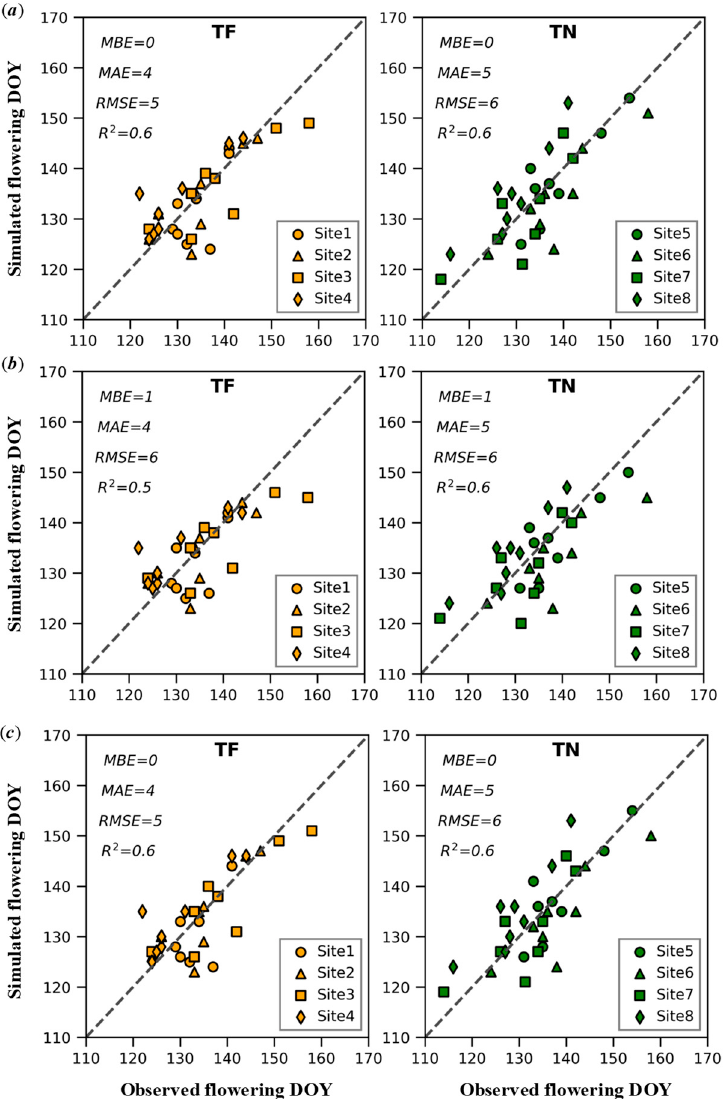
Figure 5. Comparison between observed flowering timing (DOY) and the median of the ensemble model simulations using optimized parameter values (Table S2) from ( a ) MLE, ( b ) SA and ( c ) SCE- UA. Touriga Franca (TF) and Touriga Nacional (TN) are denoted with orange and green symbols, respectively. Mean Bias Error (MBE), Mean Absolute Error (MAE), Root Mean Squared Error (RMSE) and the coefficient of determination (R 2 ) are conventional statistics for evaluating the goodness-of- fit. The geographic locations of the study sites for each variety are presented in Figure 1 and Table 1. Evaluations for individual model simulations are shown in the supplementary material (Figures S2–S4).